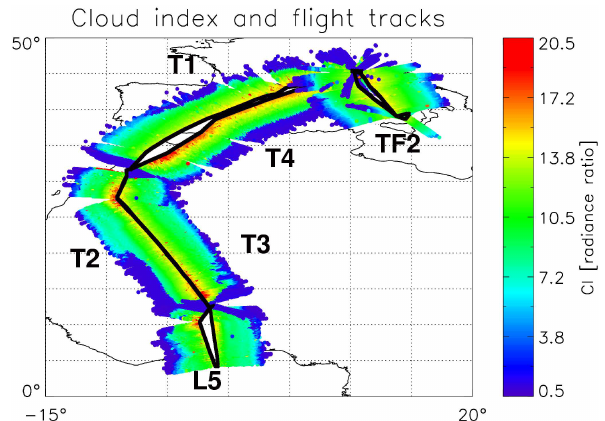
Fig. 3. Cloud index (CI) along the flight path for the transfer flights (T1–T4), the fifth local flight (L5) and the test flight (TF2) during the AMMA campaign. A CI lower than 3.5 (dark blue) indicates cloudy or optical dense